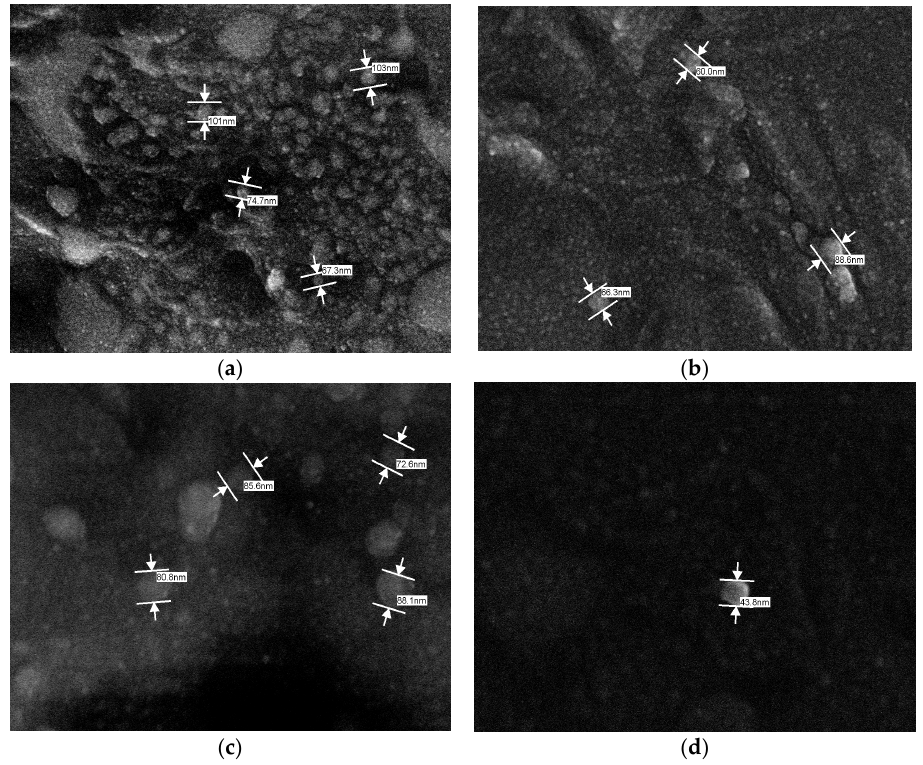
Figure 2. Photomicrograph of formulations: ( a ) F1 (magnified 50,000×); ( b ) F2 (magnified 80,000×) ( c ) F1.RES (magnified 100,000×) and ( d ) F2.RES (magnified 150,000×).